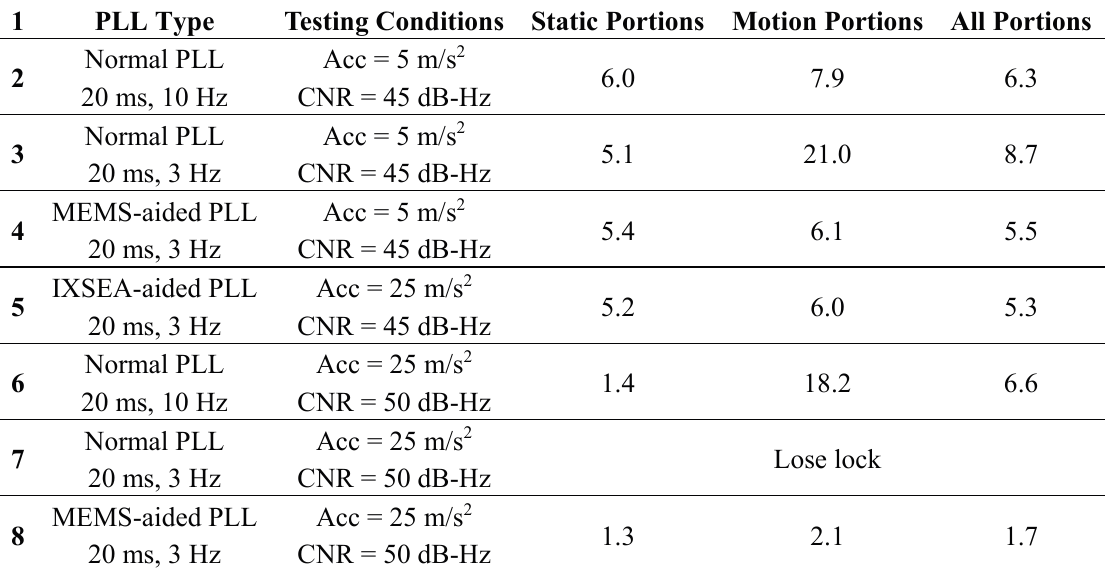
Table 3. Standard deviations of carrier phase tracking errors (in degrees) for